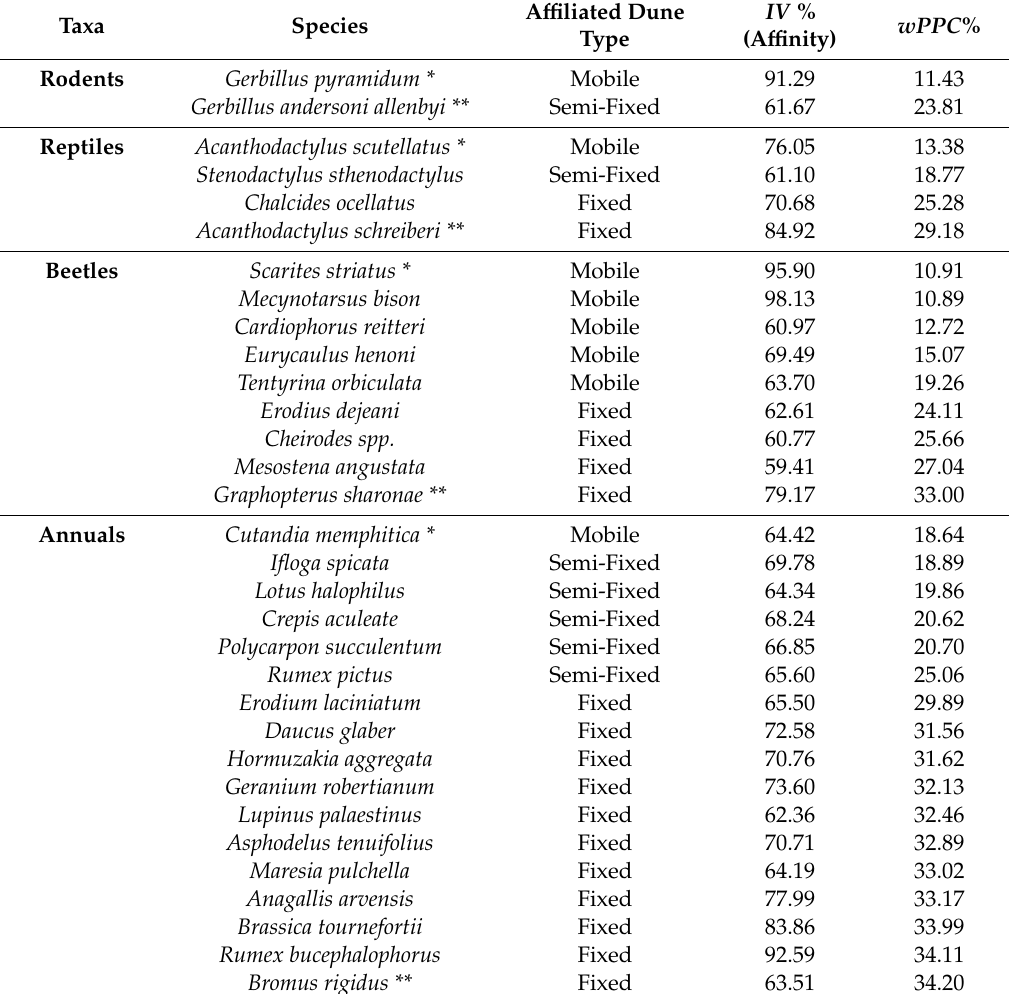
Table 1. Candidate species identified as potential indicators, using the IndVal function, the dune type they are a ffi liated to, the Indicator Value (IV) and the weighted Perennial Percentage Cover (wPPC) for each species. Species highlighted with the lowest and highest wPPC were chosen for further analysis as * Mobile dune Indicator Species (MIS) and ** Fixed dune Indicator Species (FIS)